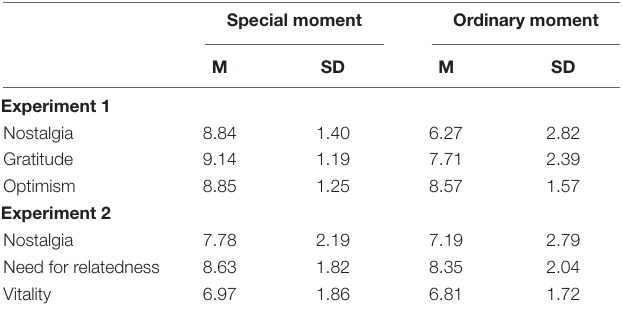
TABLE 1 | Descriptive statistics for study 1 and 2 as a function of the experimental